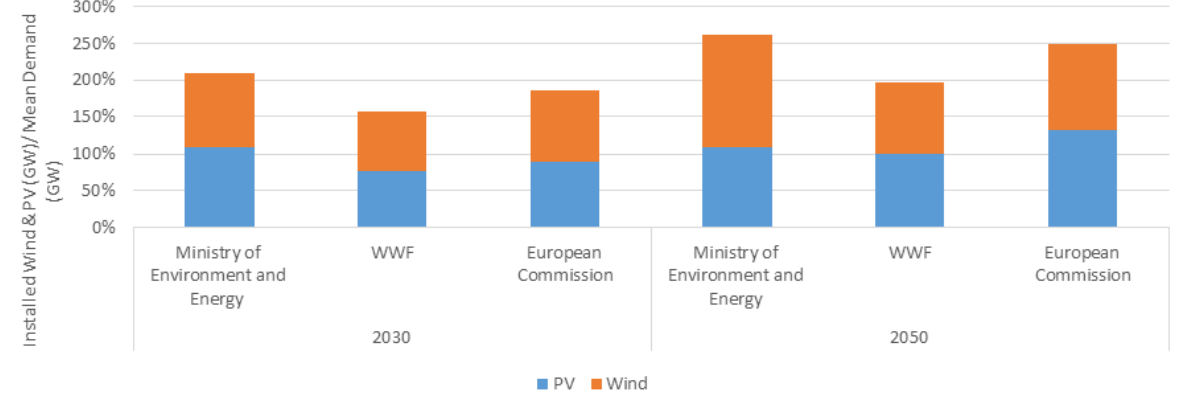
Figure 1. Normalized PV and Wind capacity (by the annual mean load) [26–29].